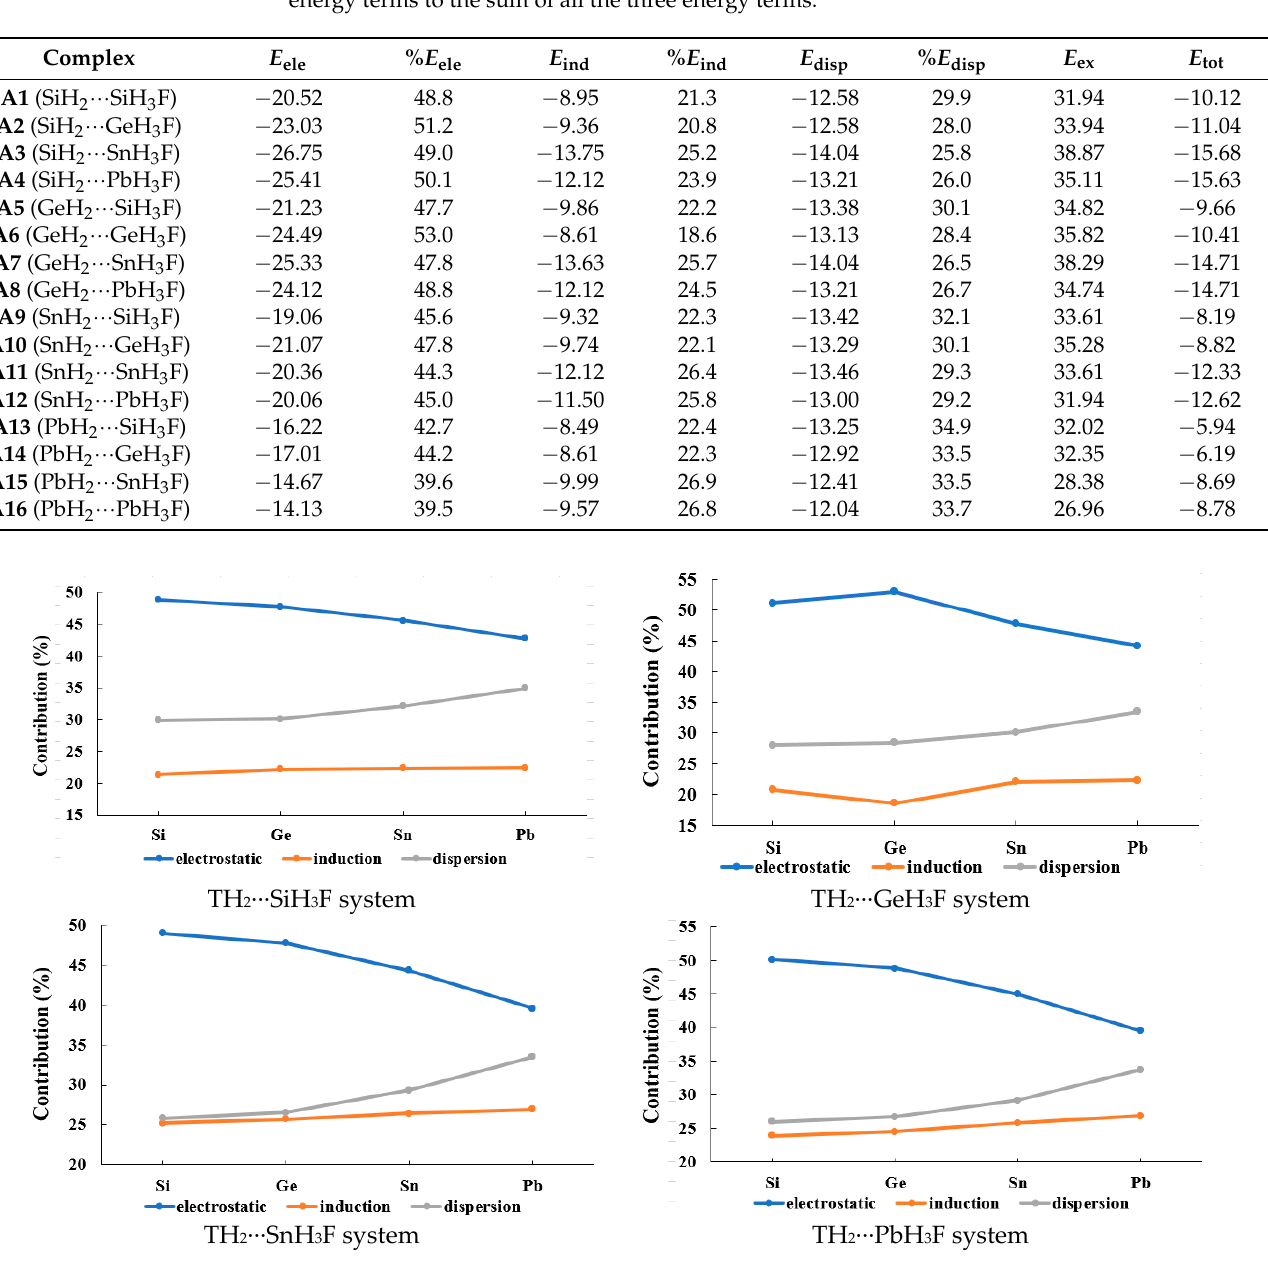
Figure 7. The changing trends of the contribution of the electrostatic, induction, and dispersion energy terms with the increase of the T atomic number for the type-A complexes. Table 3. Decomposition of the total interaction energy (Etot) for type-A complexes into electrostatic (Eele), induction (Eind), dispersion (Edisp), and exchange (Eex) energy terms. All energies in kJ/mol. The relative values in percent represent the contribution of electrostatic, induction, and dispersion energy terms to the sum of all the three energy terms.